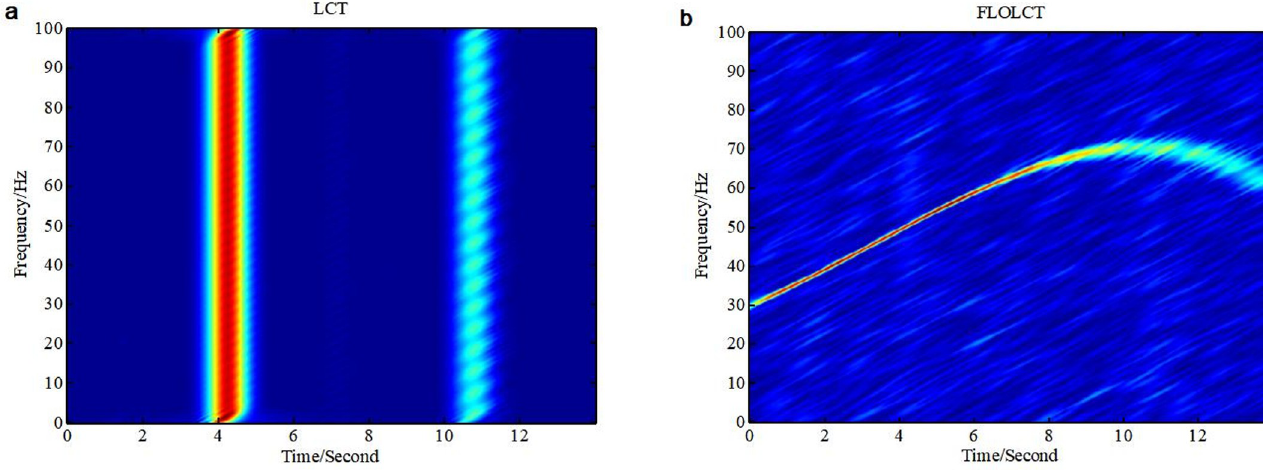
Fig 5. Time-frequency representations of the signal x ( τ ) in α stable distribution noise environment ( MSNR = 16 dB , α = 0.8). (a. LCT time frequency representation of the signal x ( τ ); b. FLOLCT time-frequency representation of the signal x ( τ )).